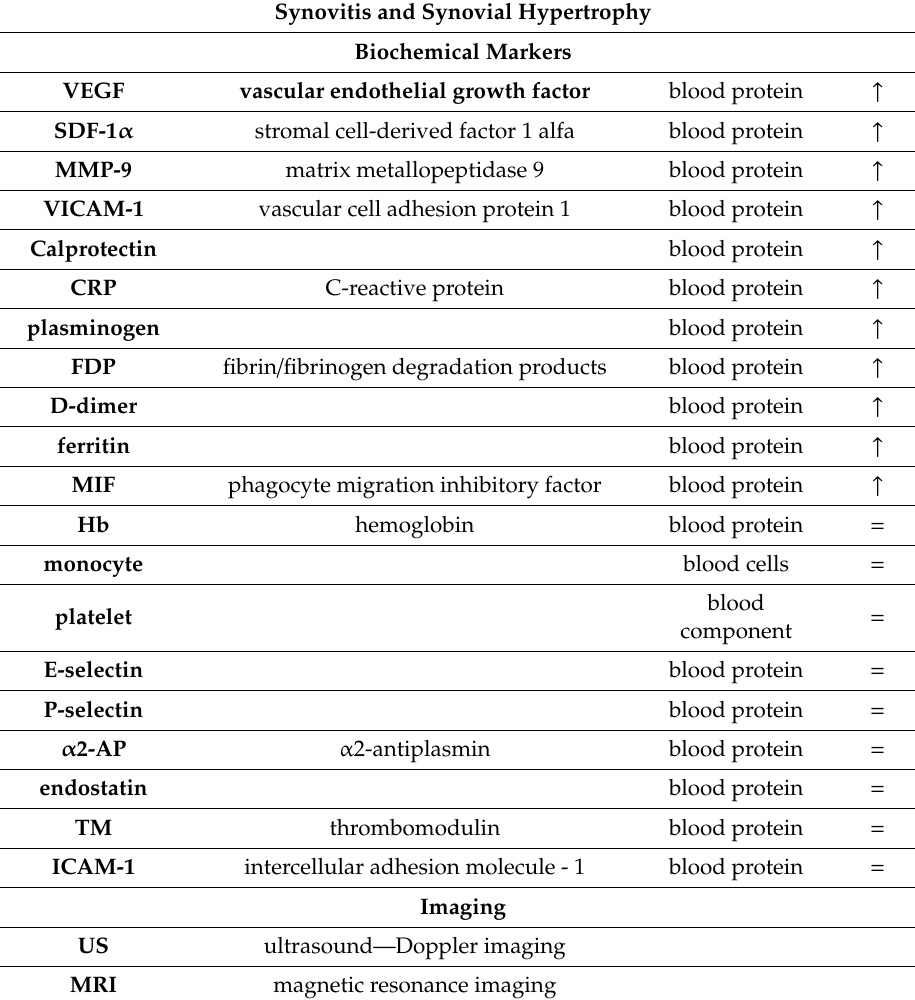
Table 3. Markers related to synovitis stage and their